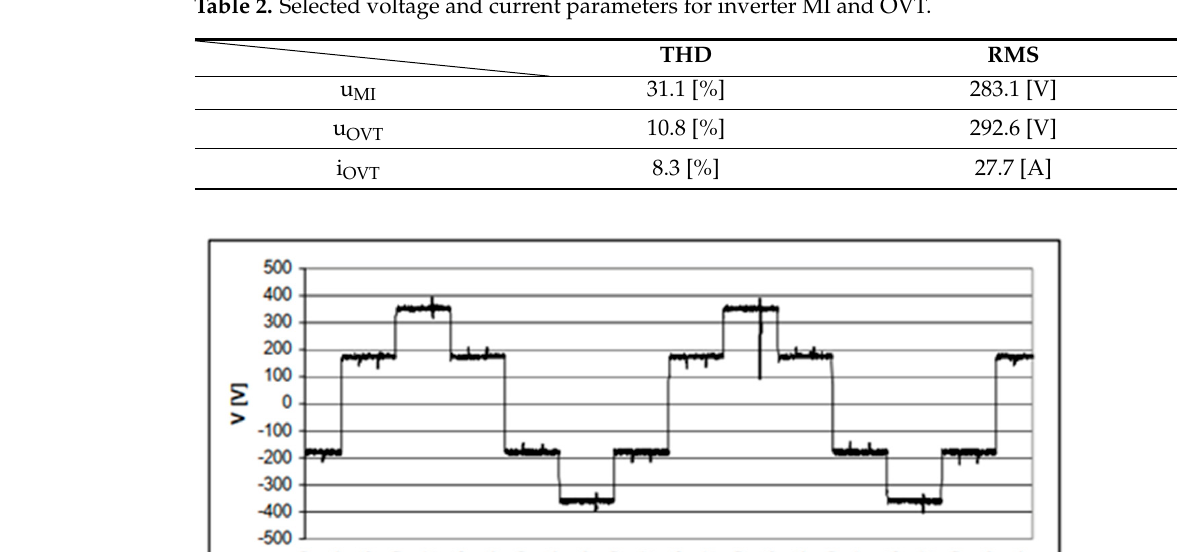
Table 2. Selected voltage and current parameters for inverter MI and OVT.